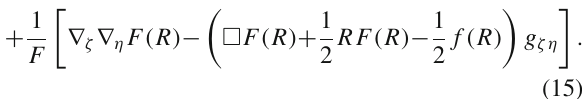
Fig. 3 Plot of embedding diagram for upper universe h ( r ) > 0 with respect to radial coordinate with slice t = const and θ = π/ 2. For a full visualization of the wormhole surface, took a 2 π rotation around the h